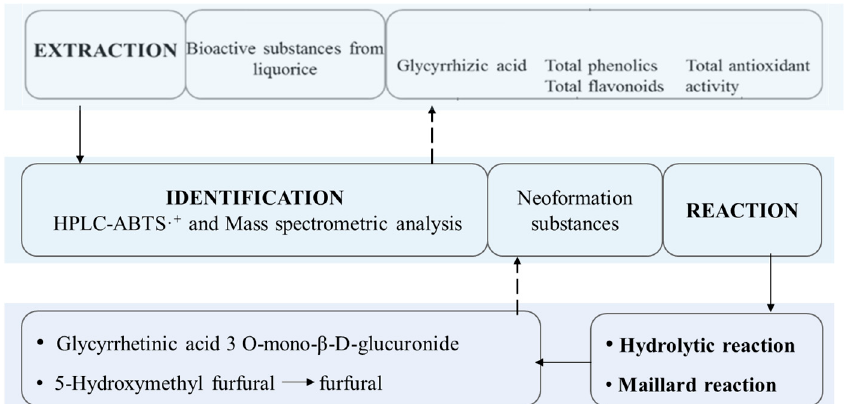
Figure 1. The study design of the thermal reactions in subcritical water extraction of bioactive compounds from licorice .